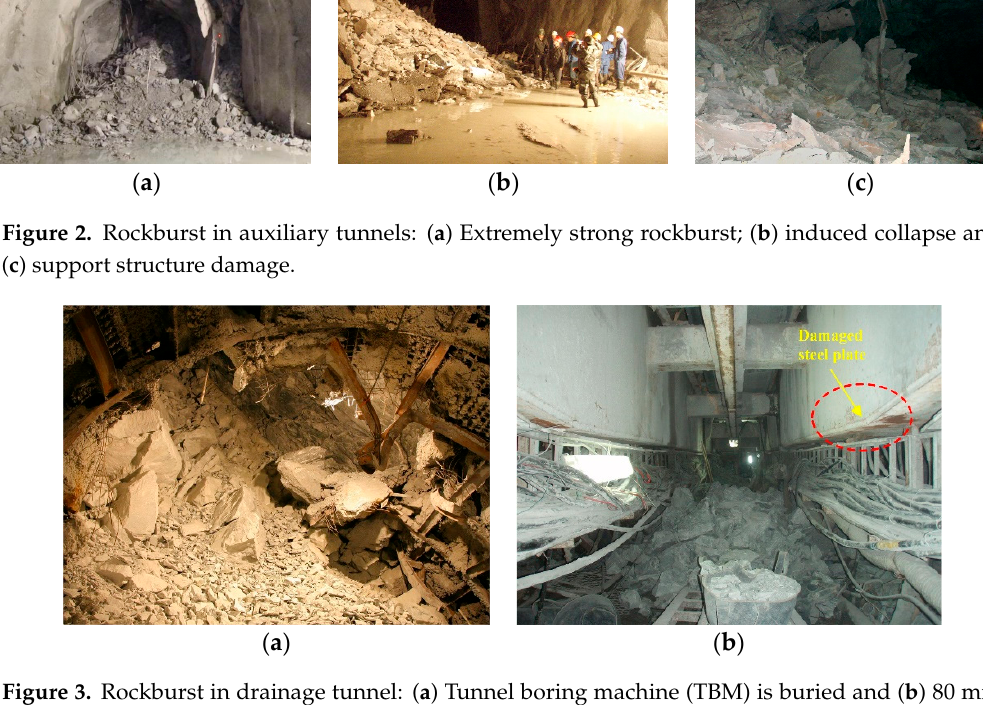
Figure 3. Rockburst in drainage tunnel: ( a ) Tunnel boring machine (TBM) is buried and ( b ) 80 mm steel plate is damaged.